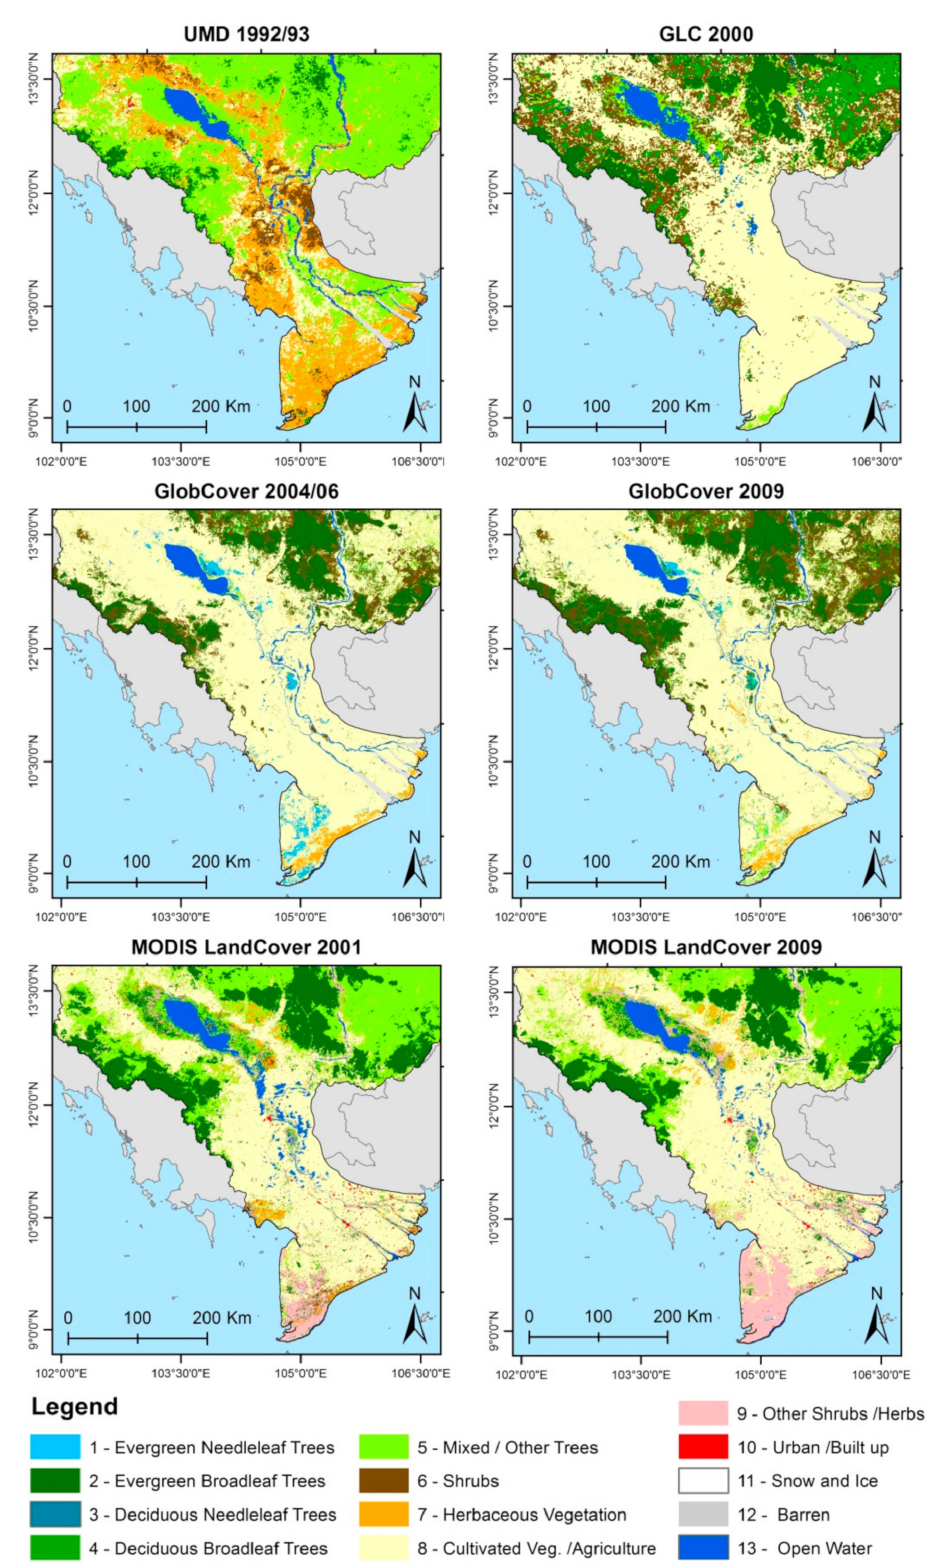
Figure 10. Comparison (after legend harmonization) and discrepancies in globally available land cover products showing the UMD (1992 / 93), GLC 2000, GlobCover (2004 / 06; 2009) and MODIS LandCover (2001 and 2009) for the larger Mekong